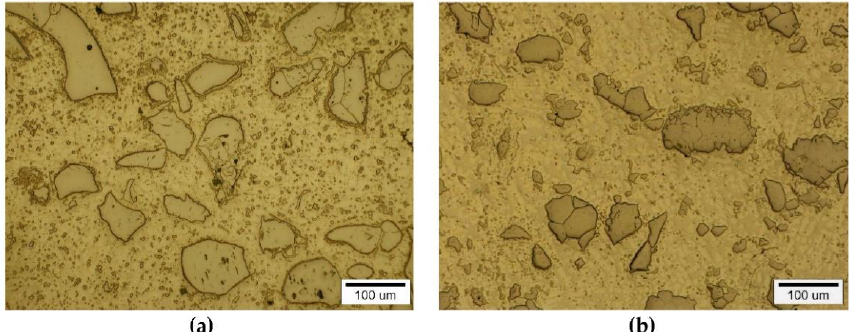
Figure 5. Optical microscope micrograph: Structure of PTAW obtained composite overlays on NiBSi alloy basis reinforced with TiC ( a ) and ZrC ( b ) particles.